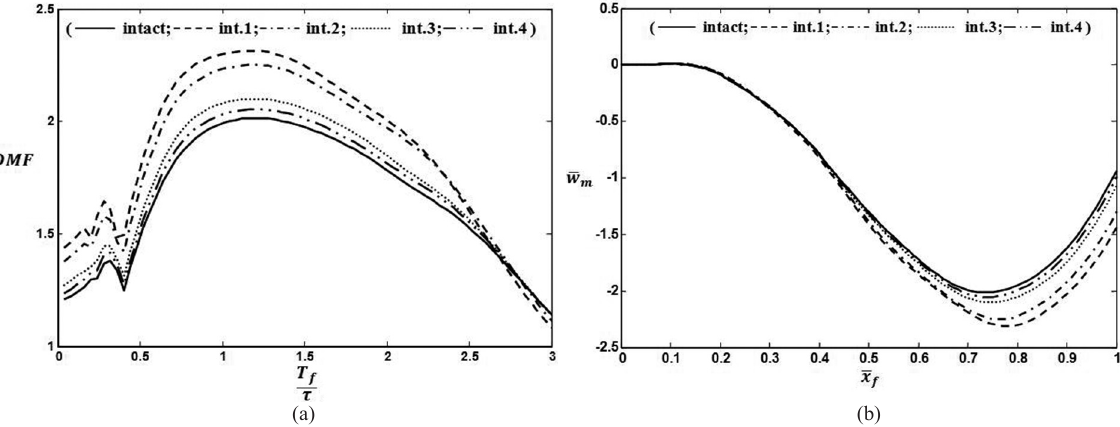
Fig. 4. a) Variation of DMF vs. T for different vertical locations of delamination, b) Variation of w m vs. x f for different vertical locations